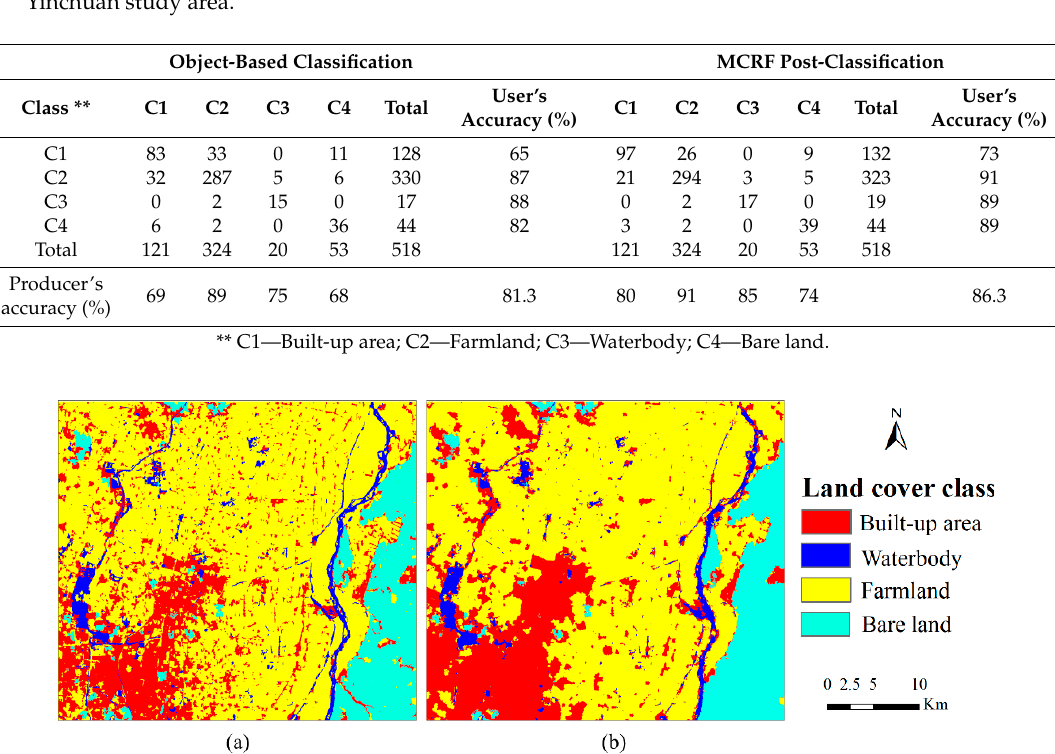
Table 4. Accuracy assessment for pre-classification and corresponding post-classification for the Yinchuan study area.